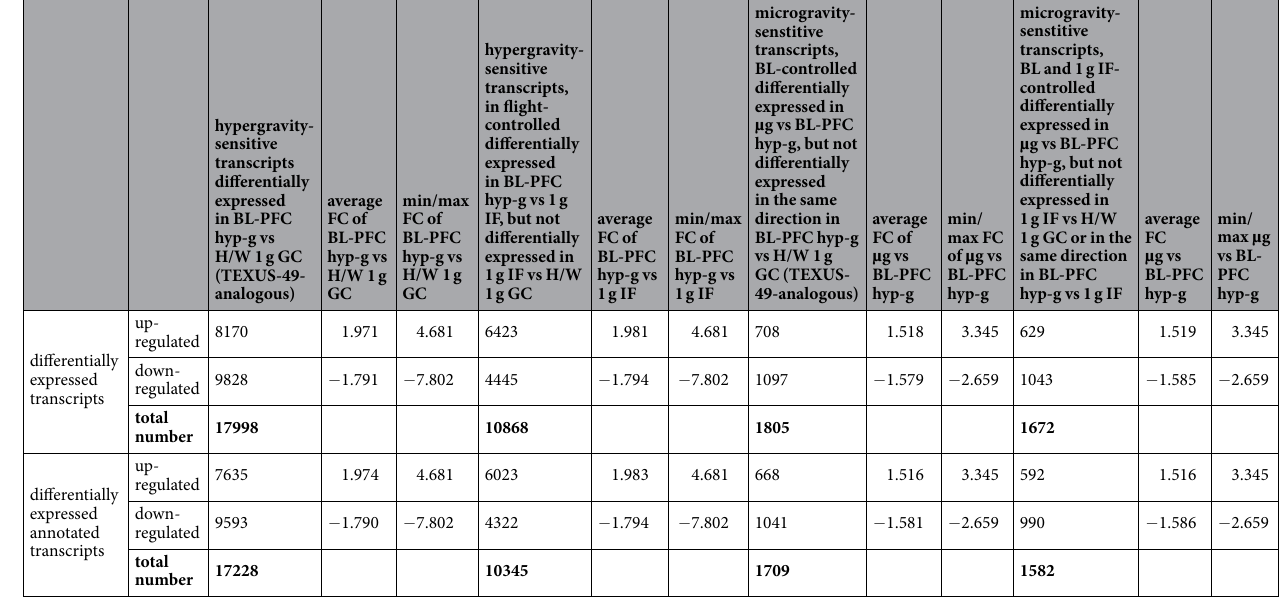
Table 3. Numbers of transcripts that are differentially expressed in response to altered gravitational conditions in the 19 th DLR parabolic flight campaign. Transcripts which were significantly changed in the control comparisons were eliminated. Differential expression is defined as t-test p-value < 0.05; fold change (FC) ≤ − 1.3 or ≥ + 1.3. FCs are ratios between the averages of linear expression values. If the ratio is < 1, FC is calculated as the negative reciprocal of the ratio.